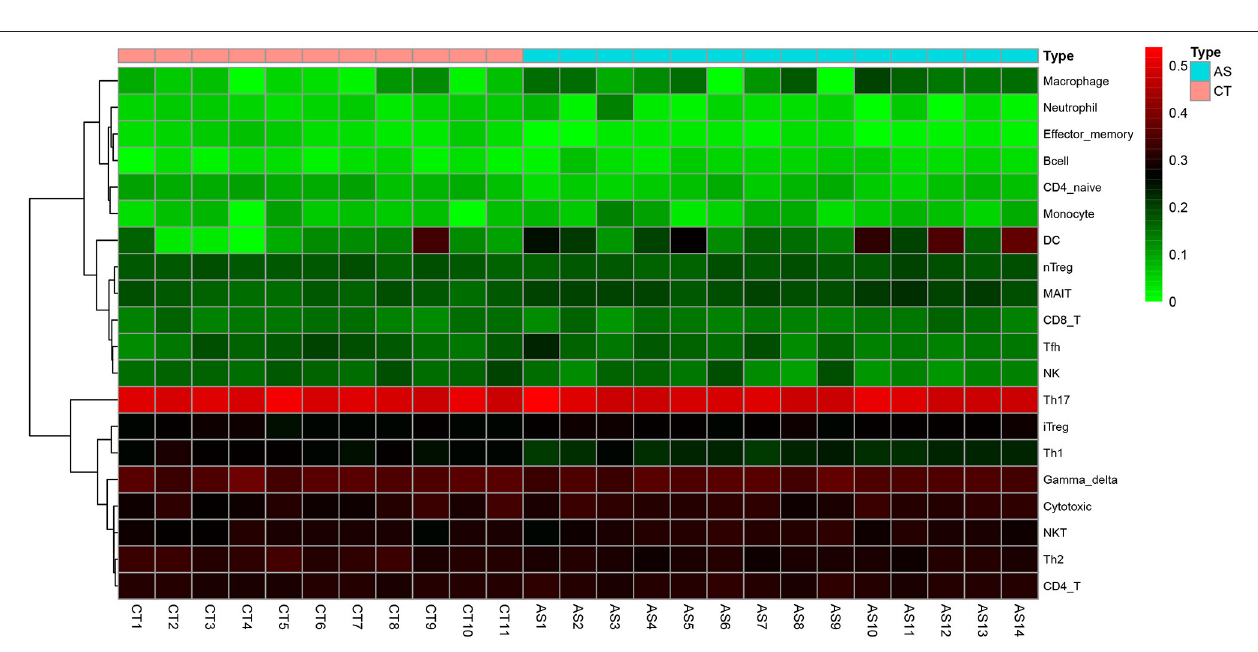
cholesterol crystals, and inflammatory cytokines ( 25). B cells have been shown to promote lesion formation